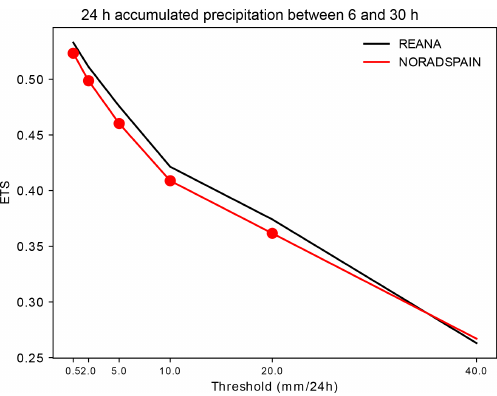
Figure 12. Equitable threat score (ETS) of 24h accumulated pre- cipitation from the 6 to 30h forecast ranges of the long forecast starting at 00:00UTC each day of the period from 5 September to 5 November 2012 computed over the AROME-WMED domain with rain gauges of the HyMeX database (version 4). The lack of dots indicates that the difference between the curves is not signifi- cant. REANA is plotted in black, and NOWPROF is in red.